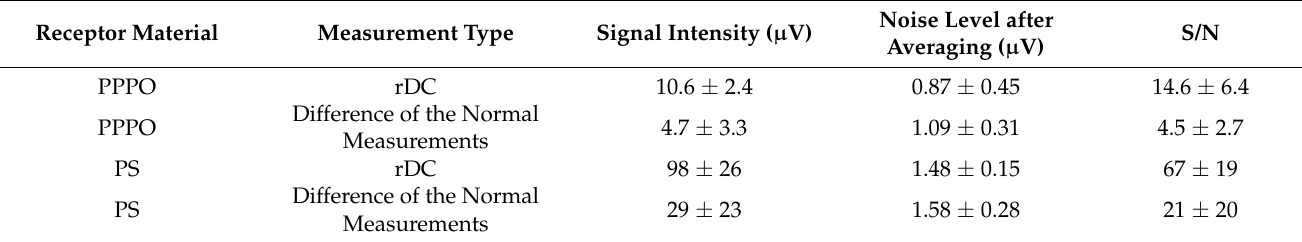
Figure 6. Summary of ( a ) the intensity and ( b ) S/N. Error bars represent the standard deviations. Table 1. Summary of the signal intensities, noise levels, and S/N.